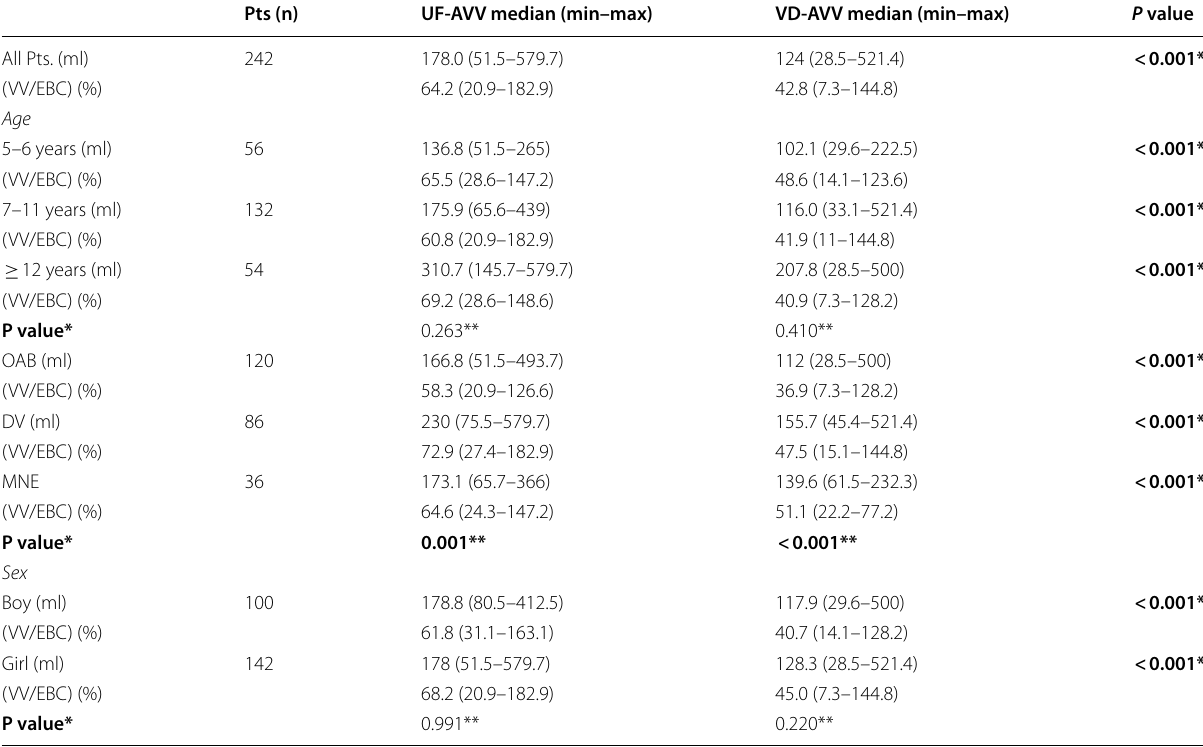
Table 2 Comparison of AVV reported by 48-h VD and UF in the entire study population and stratified according to the age, LUTD subtypes, and